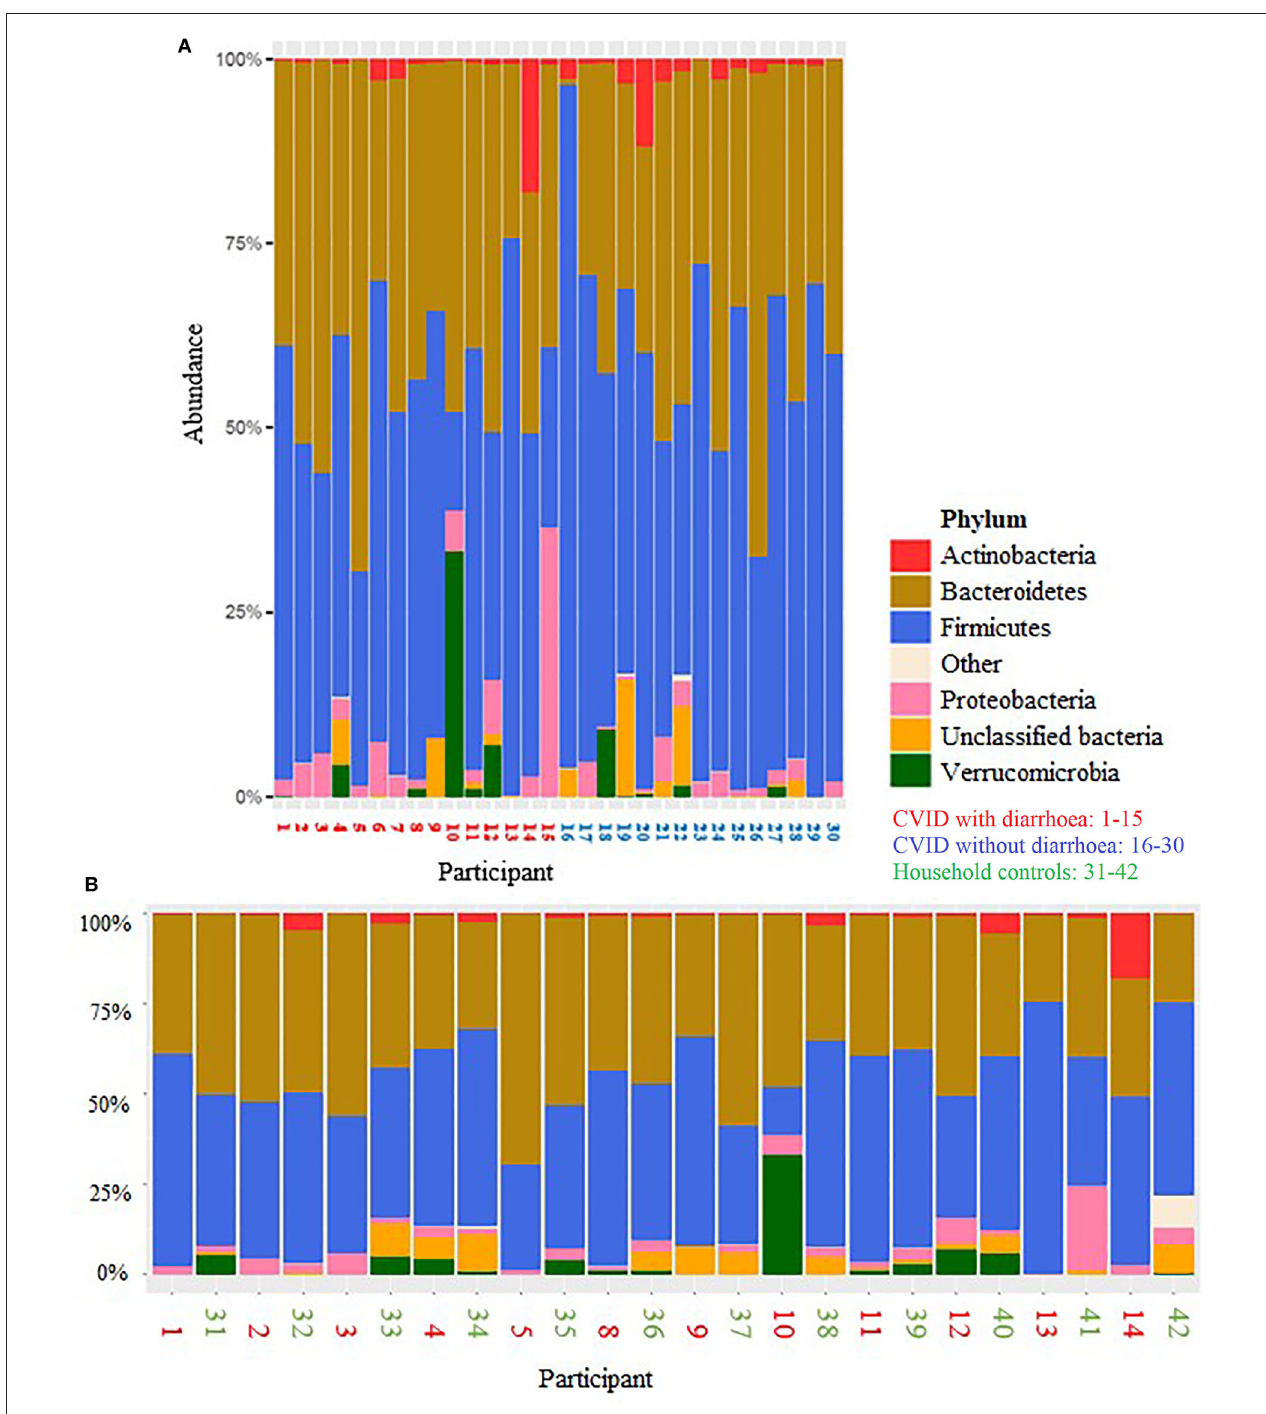
FIGURE 5 | Distribution of taxa at phylum level for (A) CVID patients with diarrhoea (red numbers) and CVID patients without diarrhoea (blue) and (B) CVID patients with diarrhoea (red) and their healthy household controls (neighbouring in green).